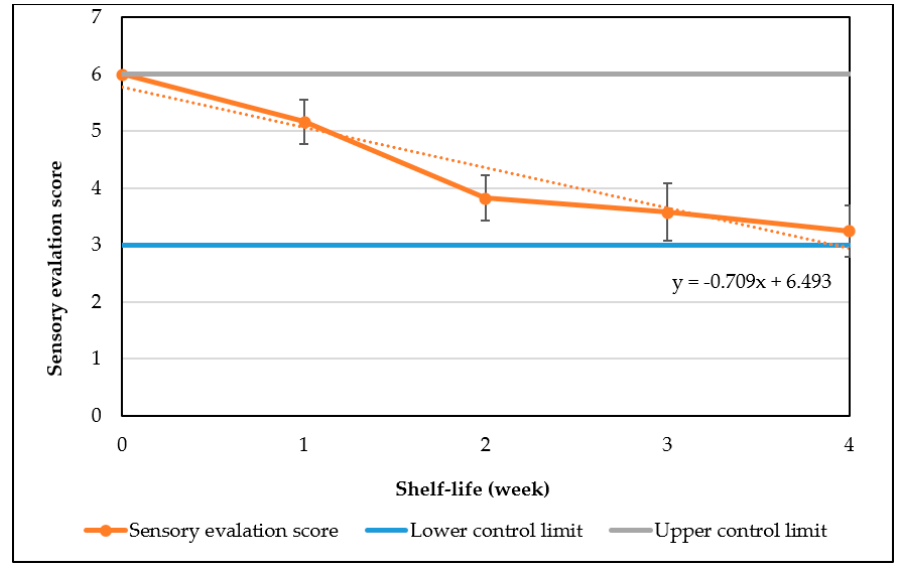
Figure 13. Sensory evaluation score in accelerated condition 37 °C.